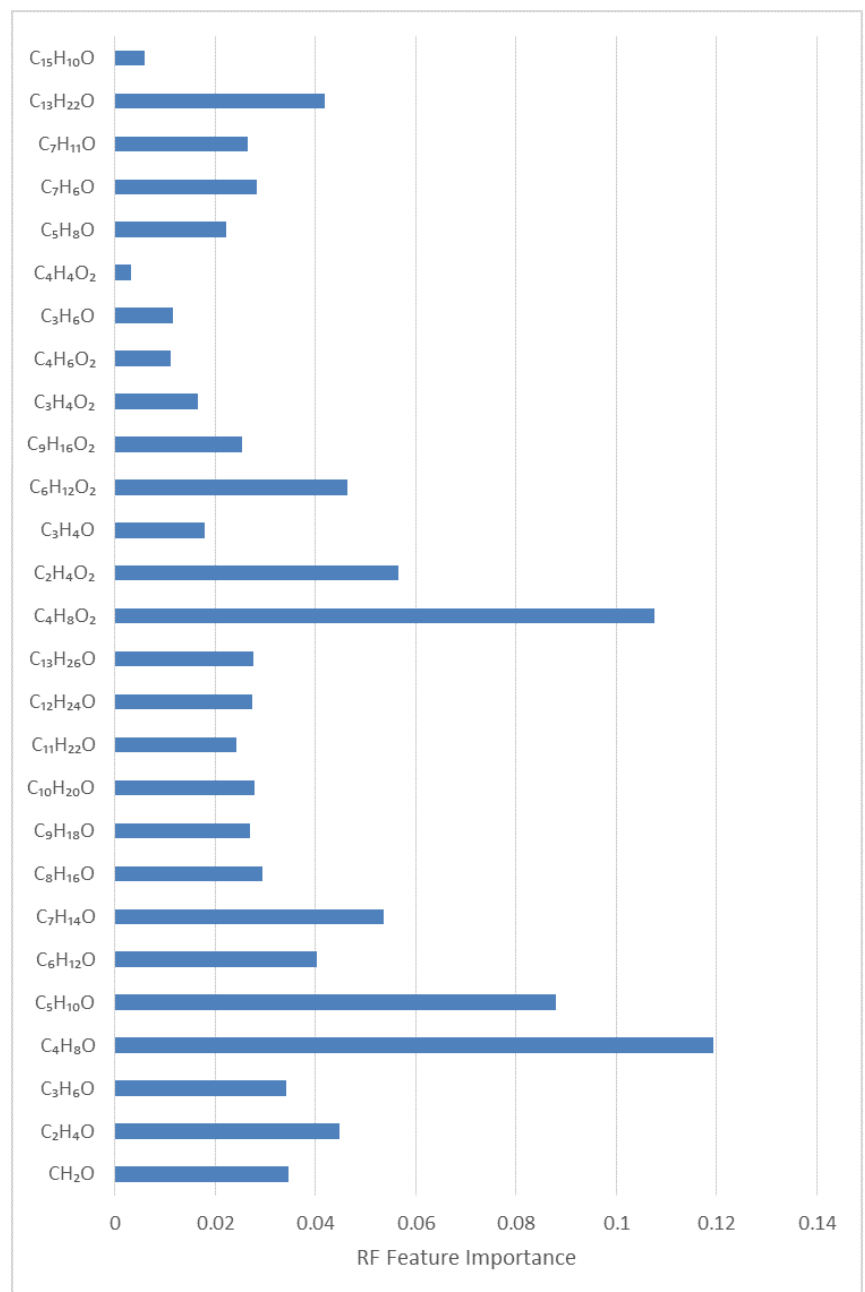
Figure 7. Random forest feature